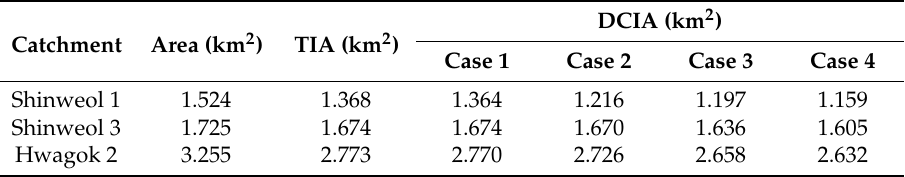
Table 3. DCIA calculated for the study